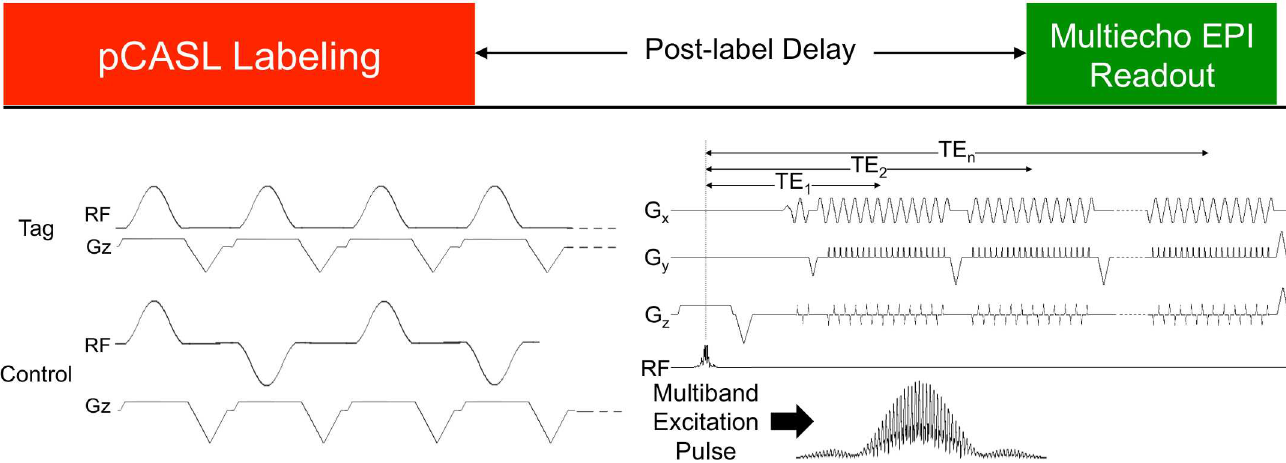
Fig 1. MBME ASL/BOLD pulse sequence design. The sequenceconsists of a pCASL labelingtrain, followedby a post-labeldelay, and a multi-echo EPI readout. The phaseis rewoundto the start of k-space after each echo and the next echo is acquired. Multibandimagingwas also utilizedby inserting a multibandexcitation pulse in place of the single band pulse. Finally, blipped-CAIPI was employedto reduce g-factor penaltiesassociated with MB imaging.